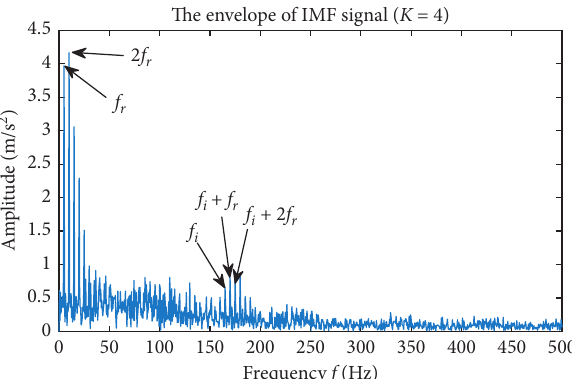
Figure 13: IMF signal envelope spectrum of inner ring.